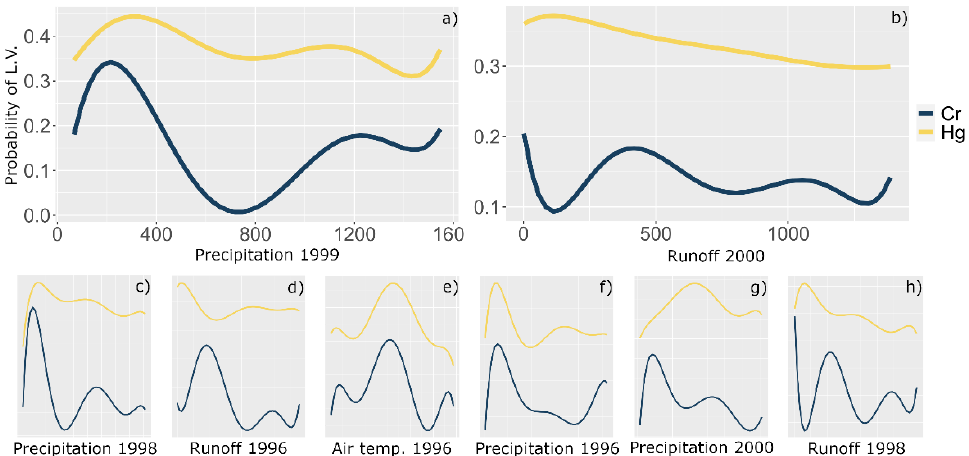
Figure 7. PDP plots for group C4. The x -axis represents a MIV, the y -axis represents the associated probability of a L.V. (lower value) classification. Each line represents the relationship for a single metal. The plots show: ( a ) Precipitation 1999 (mean annual precipitation in 1999), ( b ) Runoff 2000 (mean annual runoff in 2000), ( c ) Precipitation 1998, ( d ) Runoff 1996, ( e ) Air temperature 1996 (mean annual air temperature in 1996), ( f ) Precipitation 1996, ( g ) Precipitation 2000 and ( h ) Runoff 1998. Lines are displayed after smoothing with a polynomial regression for display purposes.